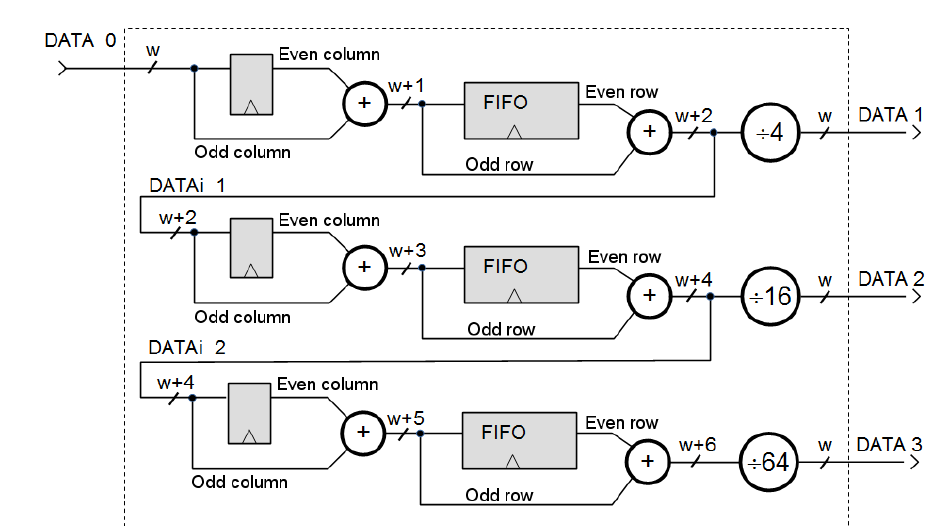
Figure 5. Generating the sequence of images of reduced resolution.